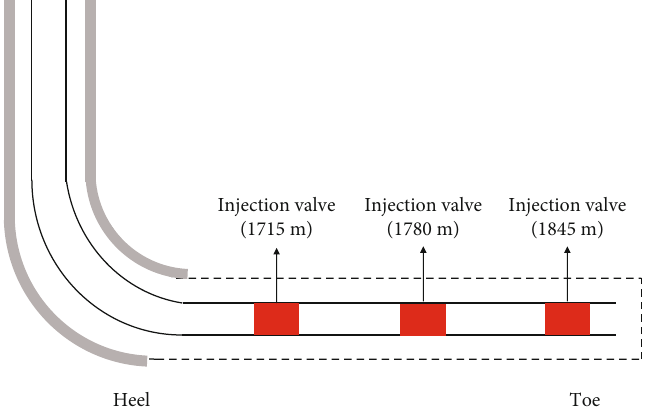
Figure 12: Schematic fi gure of Well XH27 in Liaohe oil fi eld.